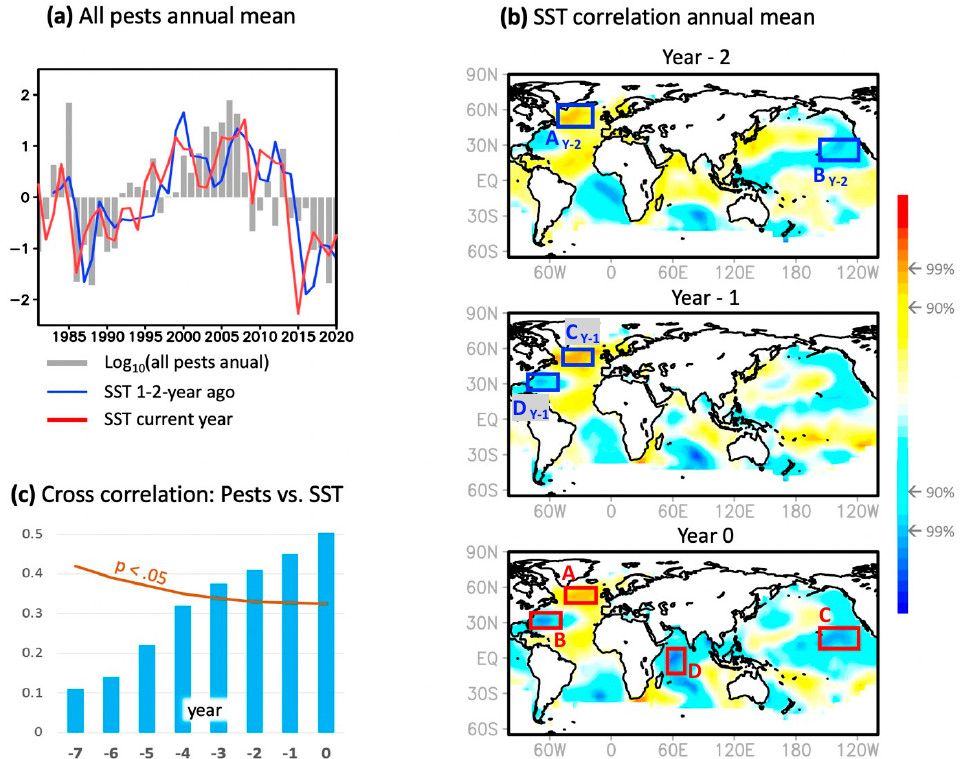
Figure 3. ( a ) Annual mean pest counts of all species from the logarithmic transformed (gray bars) superimposed with the SST indices (color lines; see text). ( b ) One-point correlation maps of the SST with the Pest Index at various time lags, as indicated at the top of each panel, where the boxes are domains used for extracting the SST values (see text), while the color bar indicates the significance levels. ( c ) Cross-correlation between the Pest Index and SST Index of various lag times in years (x-axis); red line indicates 95% confidence interval at each time